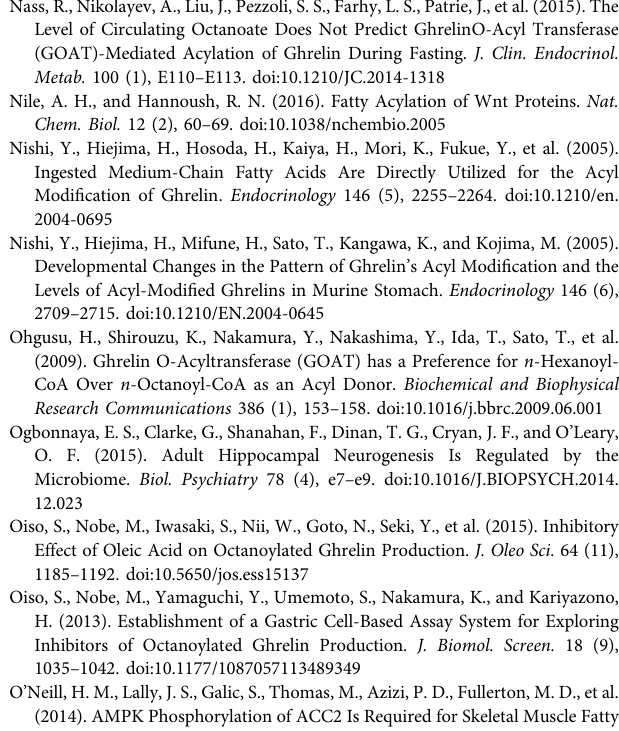
(2014). AMPK Phosphorylation of ACC2 Is Required for Skeletal Muscle